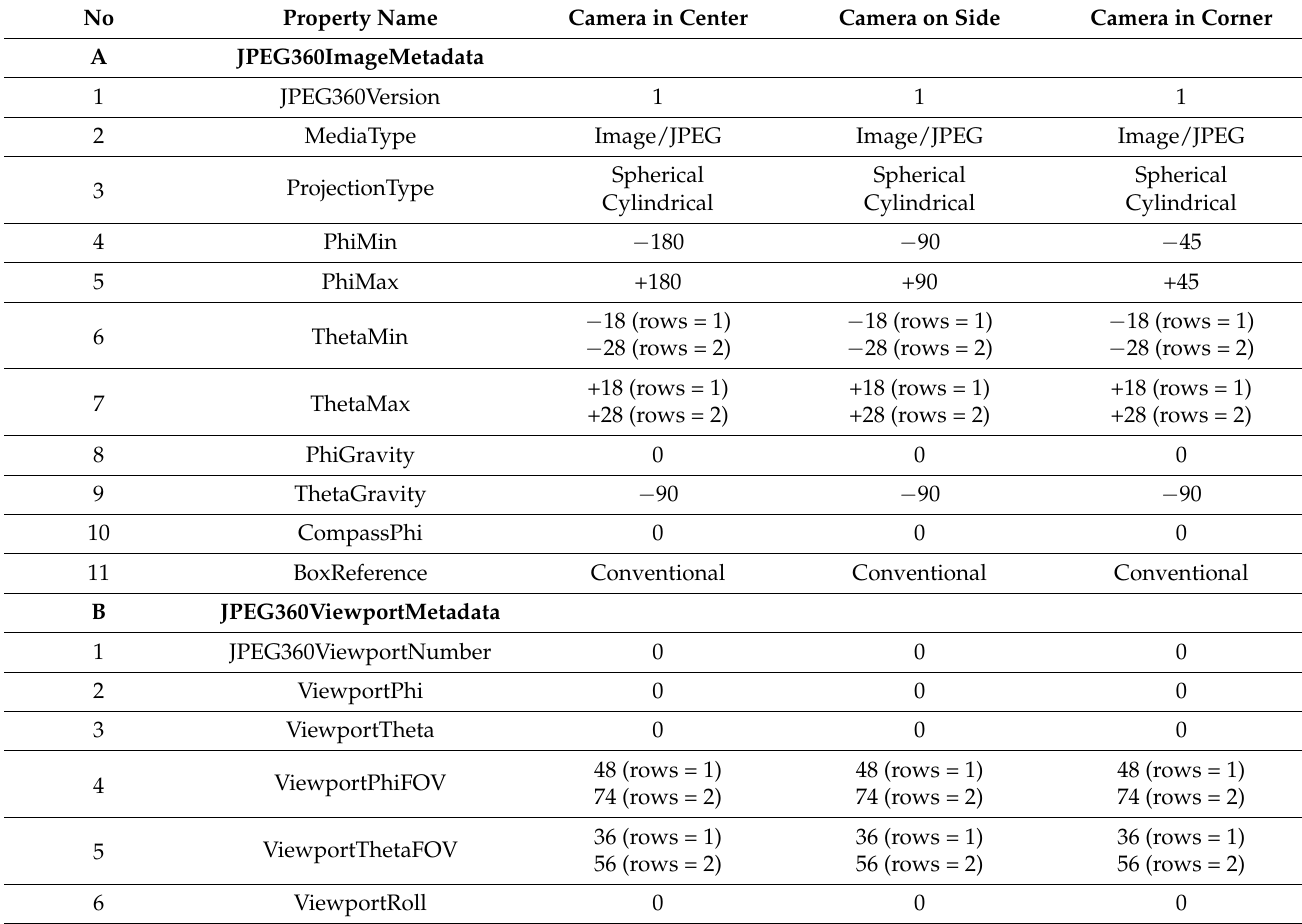
Figure 14. Twenty unstitched images of panorama from center of room (each image is originally captured in 1920 × 1080 resolution). Table 7. JEPG 360 metadata values for PTZ